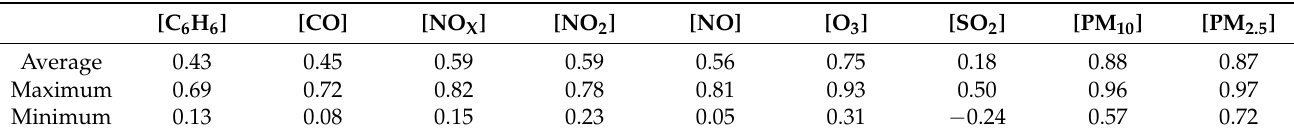
Table 13. Cross-correlation average, maximum and minimum values between Roma Green Band and suburbs or province stations of all pollutant concentrations in